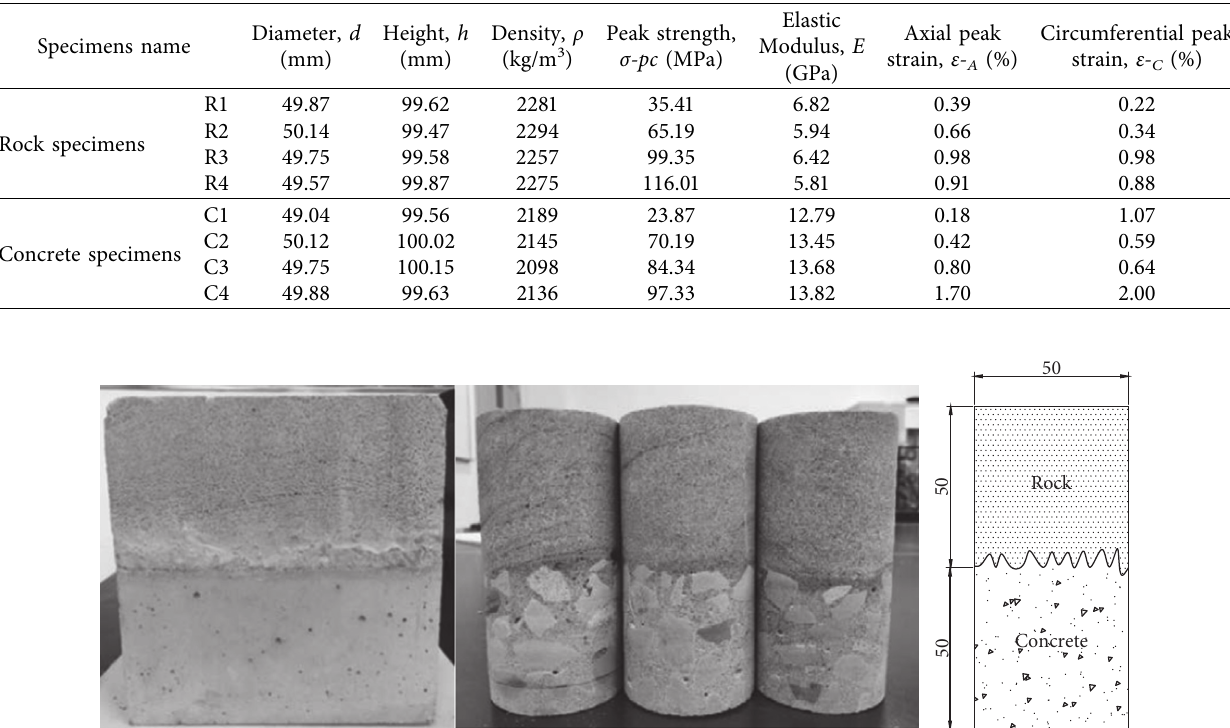
Table 1: Basic physical parameters of rock and concrete specimens